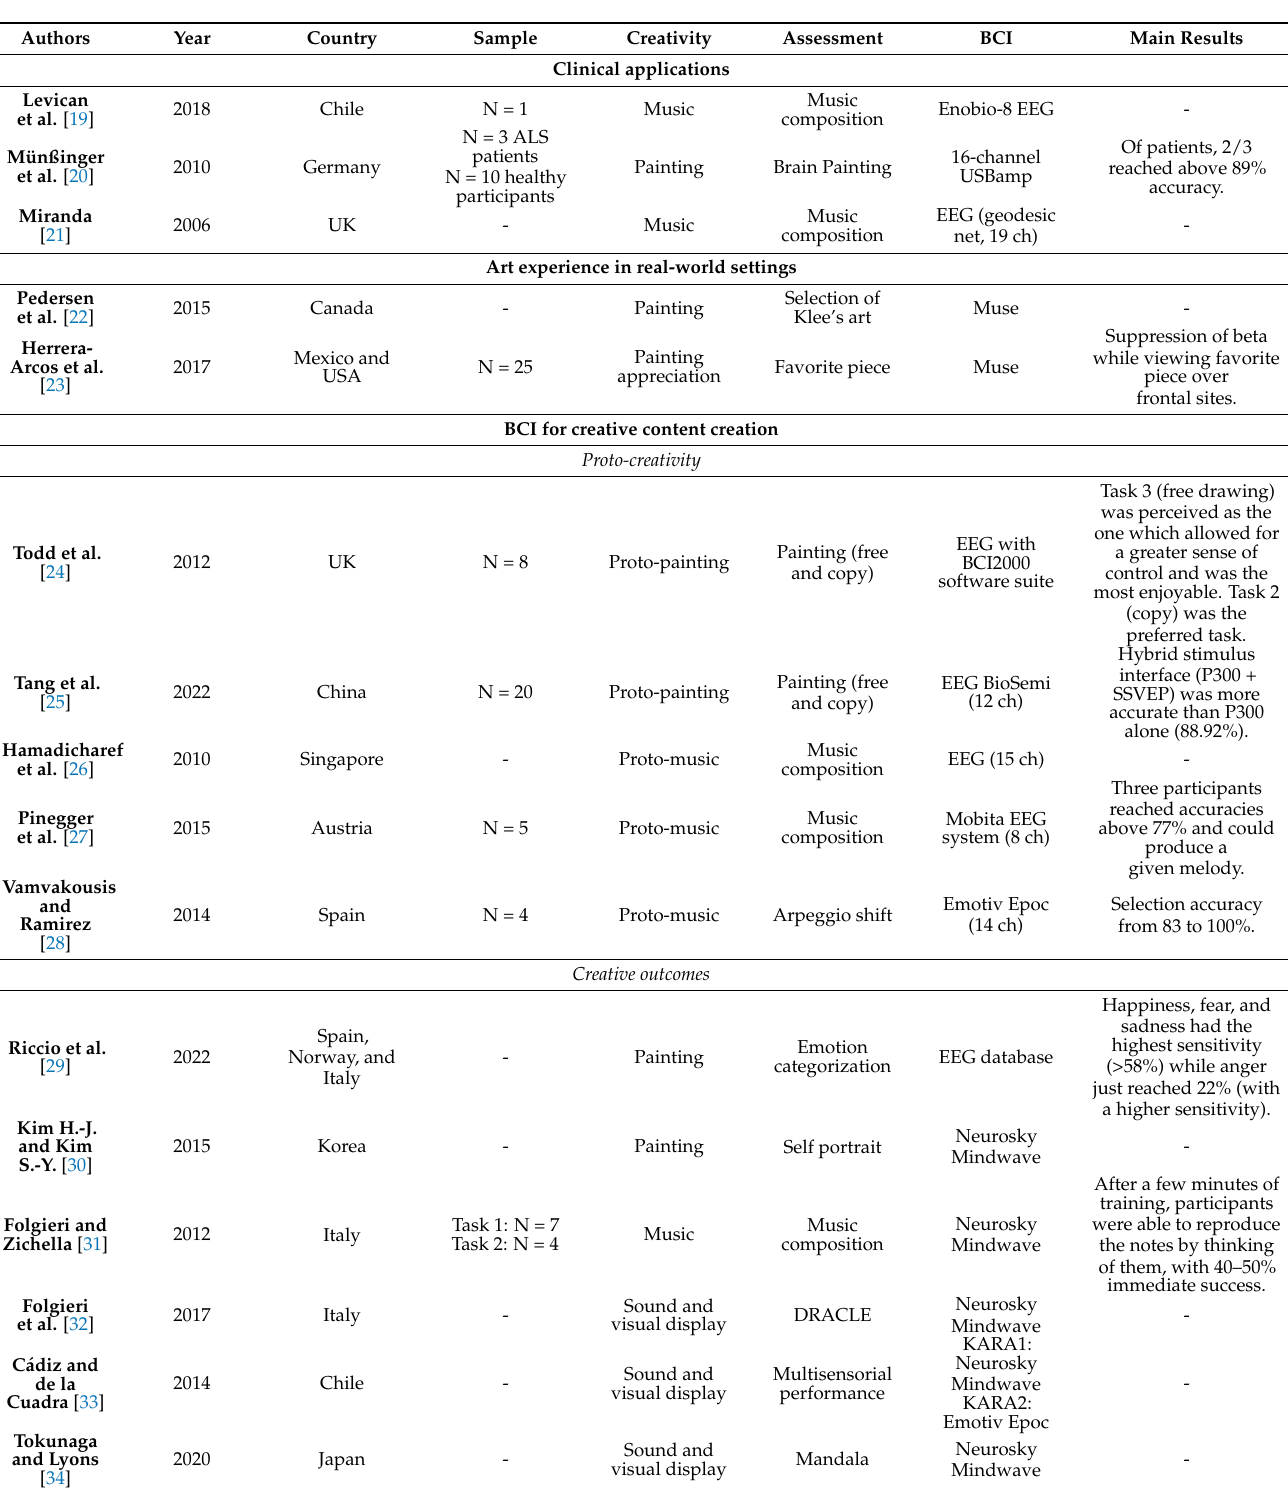
Table 1. Coordinates of the selected